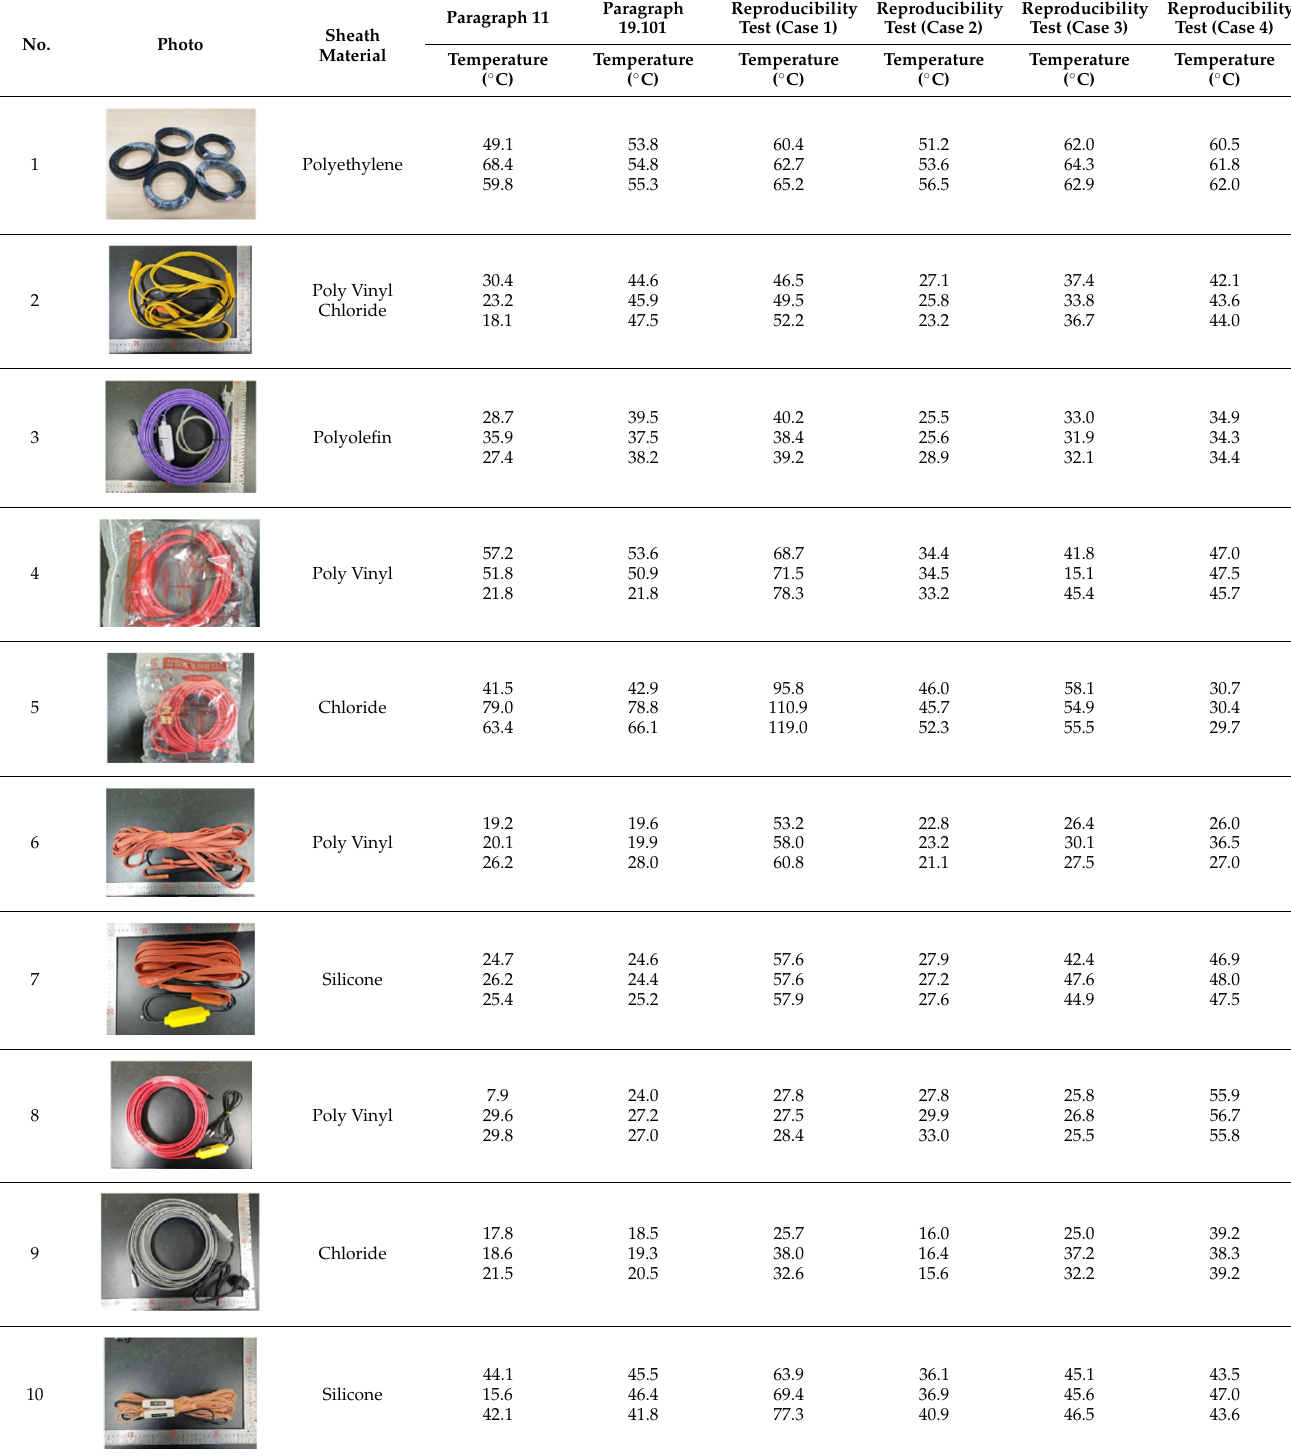
Table 4. Comparison of the results of the K 10013 test and reproducibility test.